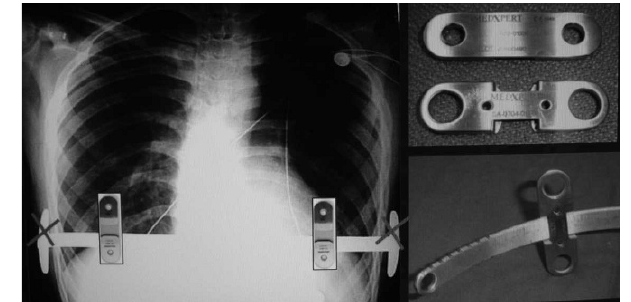
Figure 2 - New positioning of the